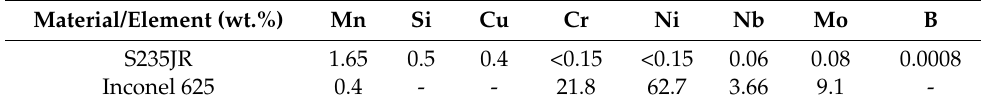
Table 1. Chemical composition of the used materials. Material/Element